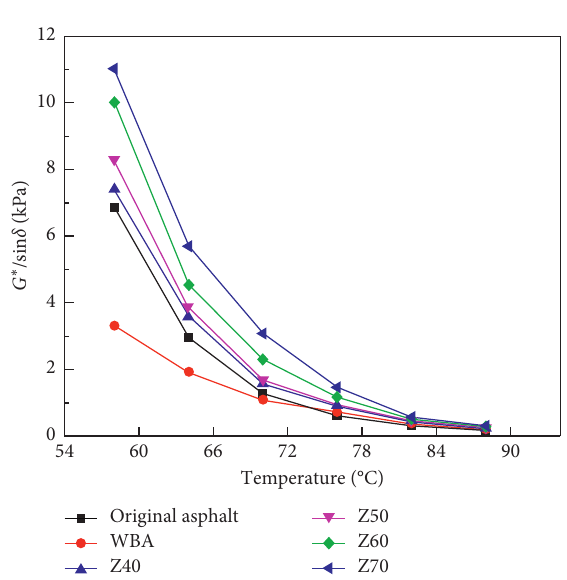
Figure 7: Test results after RTFOT-aging of all asphalt.